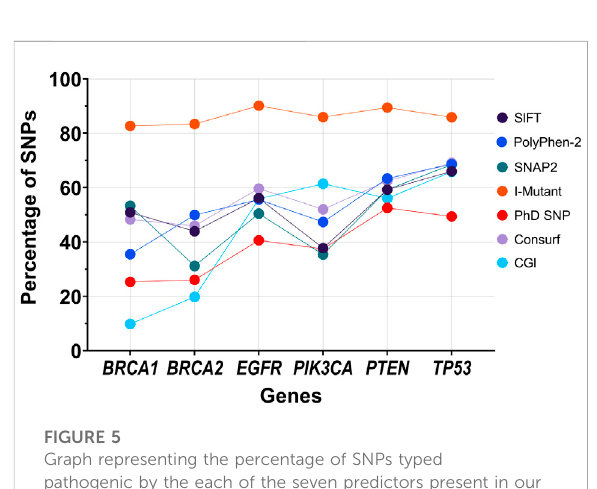
FIGURE 5 Graph representing the percentage of SNPs typed pathogenic by the each of the seven predictors present in our